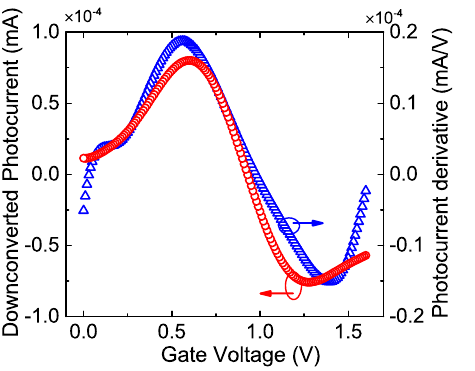
Fig. 6 Downconversion ef fi ciency vs V GS . Red curve: cut of Fig. 5c for V = 200 mV. Blue curve: cut of Fig. 5b for V DS